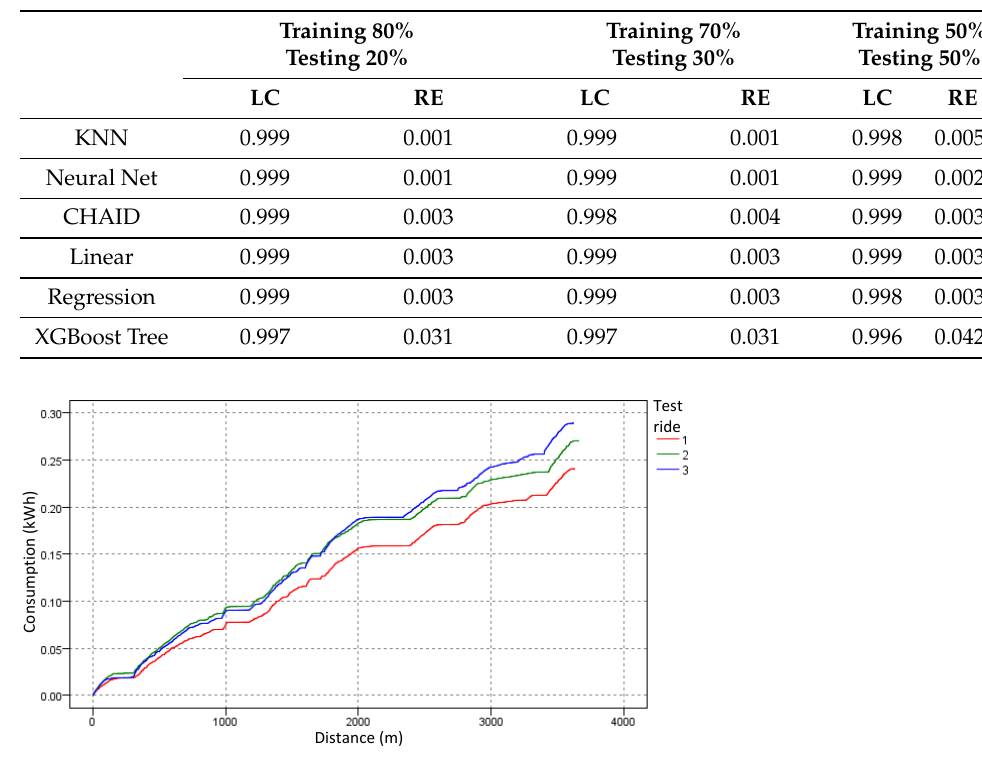
Fig. 1 Actual consumption on the test route Figure 20. Actual consumption on the test